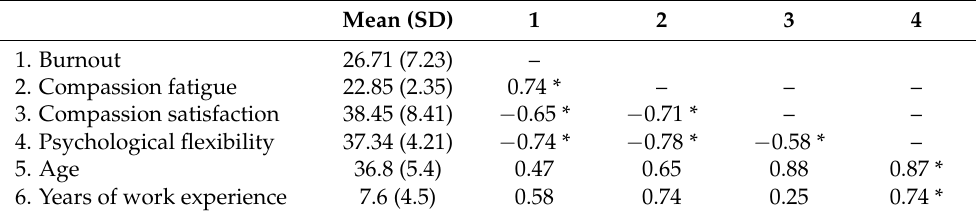
Table 2. Correlational study between psychological flexibility, burnout and compassion fatigue, and compassion satisfaction variables.